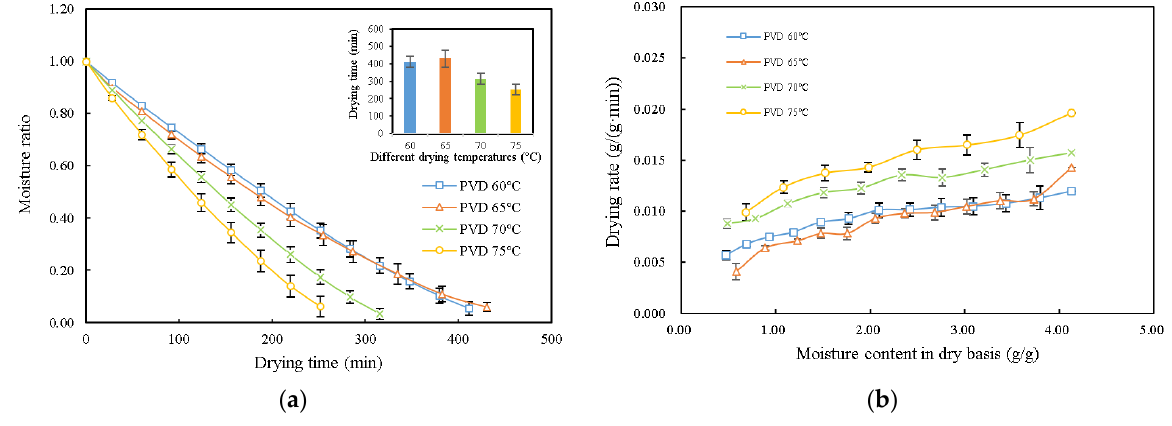
Figure 3. Drying curves and drying rate curves of persimmon slices under different PVD (12:4 min) conditions. PVD: pulsed vacuum drying. ( a ) Moisture ratio versus drying time; ( b ) drying rate versus moisture content in dry basis.